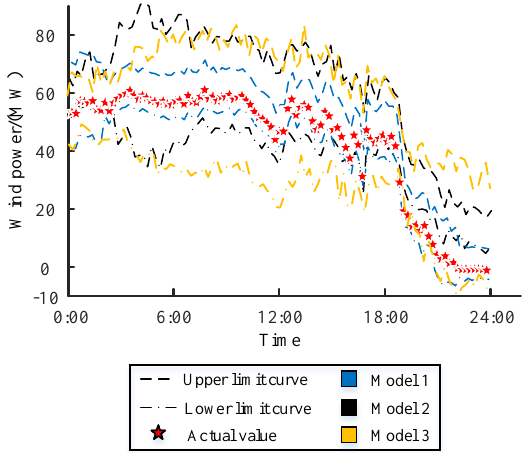
Figure 5. Models Figure 5. Models comparison. Table 2. Models comparison at different confidence levels.